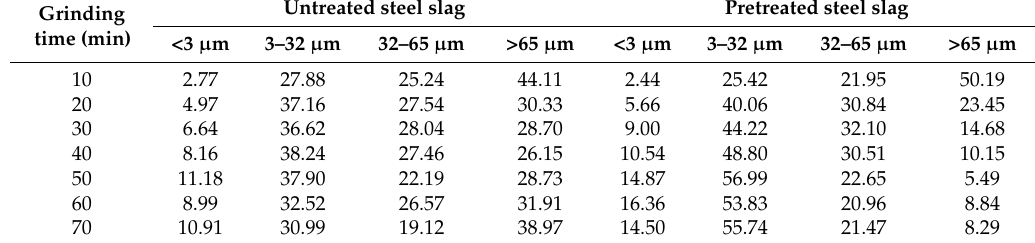
Table 5. Particle size distribution of ground steel slag powder under different grinding time (%). Grinding time (min)